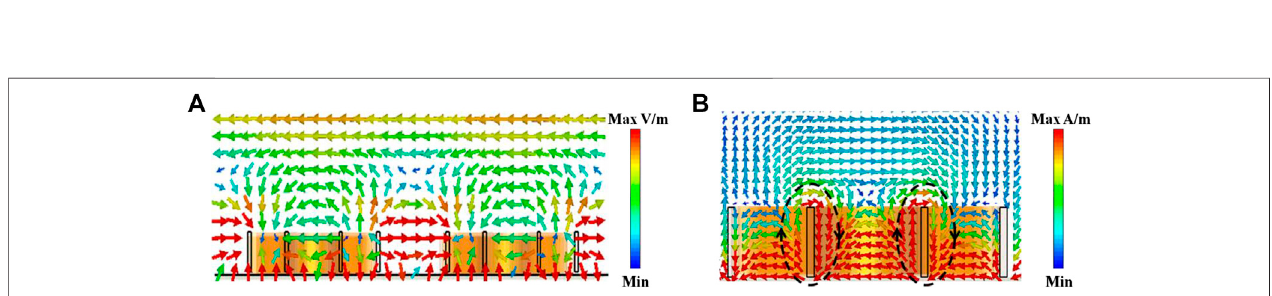
FIGURE 5 | Simulated (A) electric, and (B) magnetic fi eld distributions within the 3D MA.